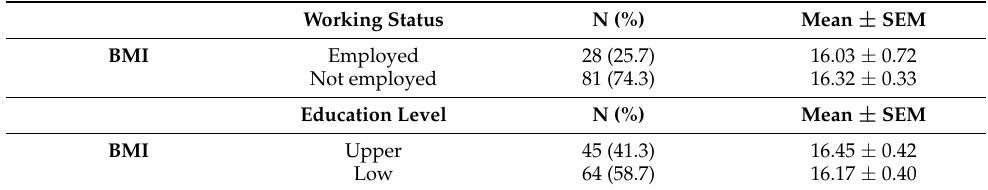
Table 5. Association of maternal, employment status, educational level and income level and BMI for age and sex of